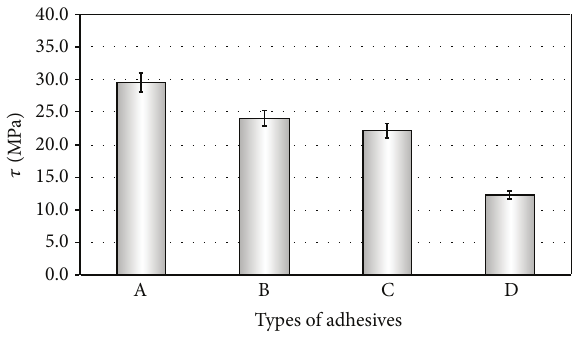
Figure 5: The final values of the shear strength under tension.